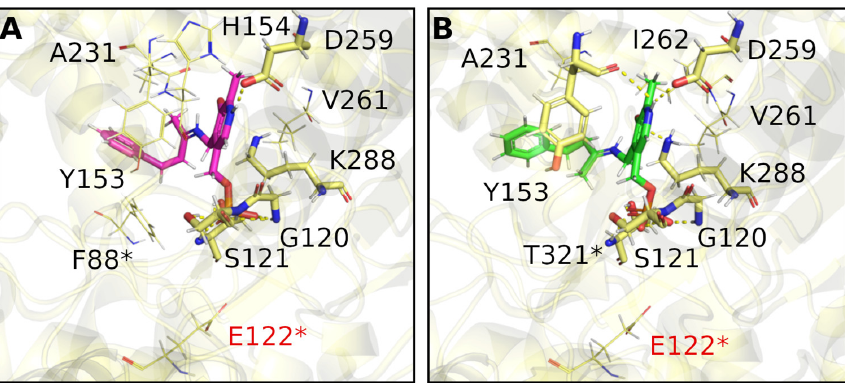
Figure 2. Binding poses of compounds 2a ( A ) and 1a ( B ) in the binding site of the C. violaceum ATA obtained by molecular docking. Hydrogen bonds are shown by yellow dashed lines. Amino acids marked with * show that they belong to the B chain; those colored red represent unfavorable contacts.